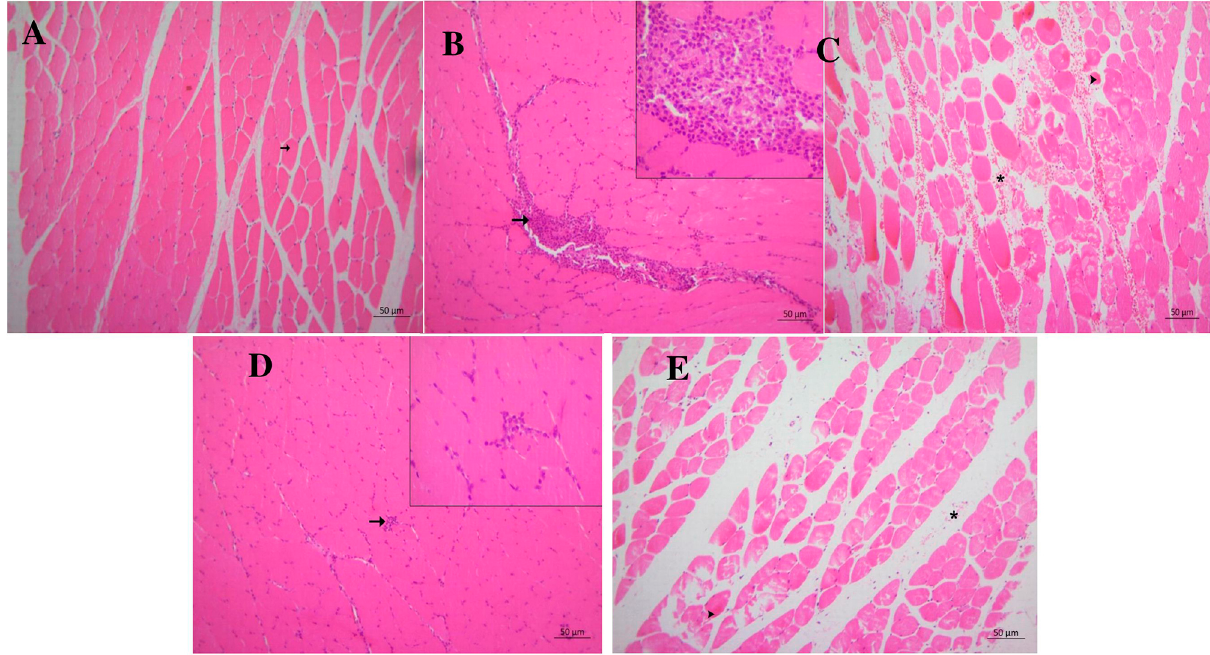
Figure 4- Histopathological evaluation of the inner cheek tissue in the groups. A . Inner cheek tissue of the healthy group. Normal histological appearance (arrow) of muscles and fibers (HxE). B . Inner cheek tissue of the MTXG group. Severe inflammatory cell infiltration (arrow) in interstitial areas (HxE). C . Inner cheek tissue of the MTX group. Severe hemorrhage (*) and appearance of degenerative muscle fibers (arrowhead) in interstitial areas (HxE). D . Buccal tissue belonging to the TMTX group. Mild inflammatory cell infiltration (arrow) appearance in interstitial areas. (HxE). E . Buccal tissue belonging to the TMTX group. Mild hemorrhage (*) in interstitial areas and muscle fiber degeneration (arrowhead)